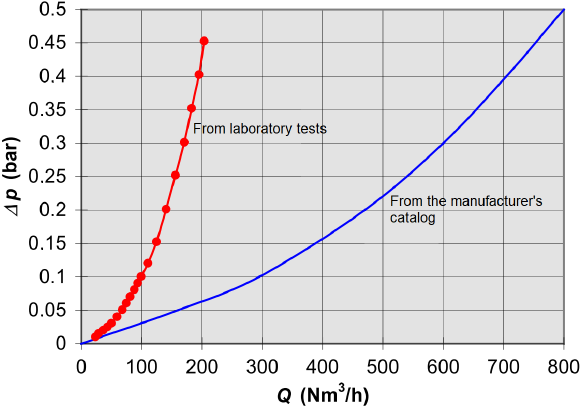
Figure 13. Comparison between the characteristic curve given by a manufacturer and the results of a laboratory test—air valve with nominal diameter of 2 inches in the expulsion